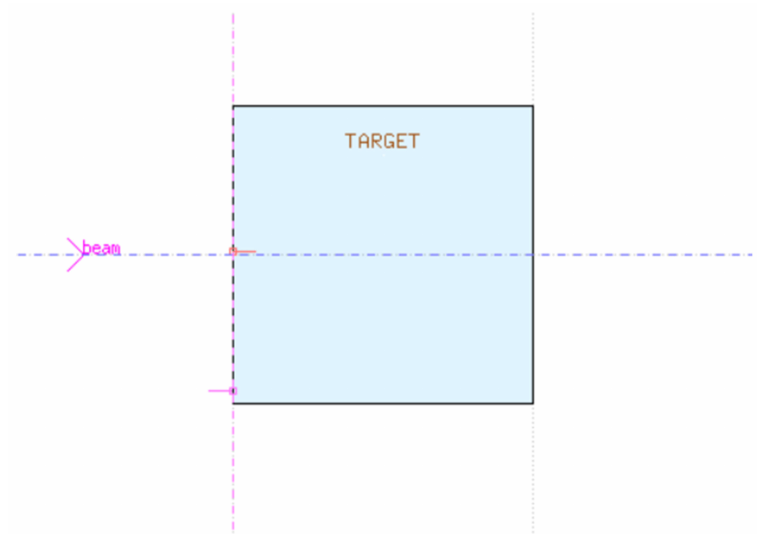
Figure 3. Geometry